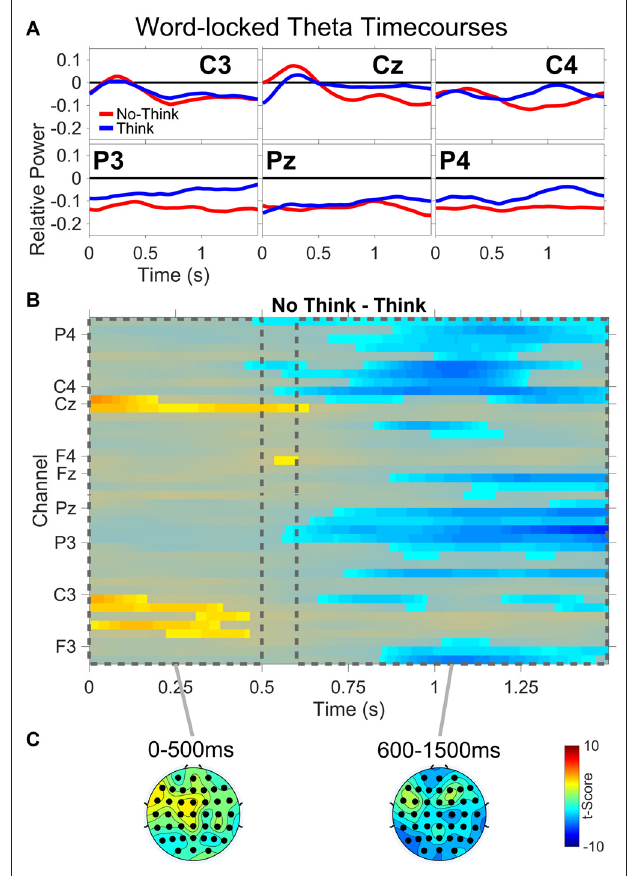
FIGURE 5 | Word-locked theta power. (A) Average power time courses for three central (C3,Cz,C4) and three parietal (P3,Pz,P4) electrode channels. (B) No-Think—Think significant t -scores ( p < 0.05) at all electrodes and time points. (C) Topographies of t -scores for No-Think—Think, averaged over the duration of two time periods (0–500 ms and 600–1500